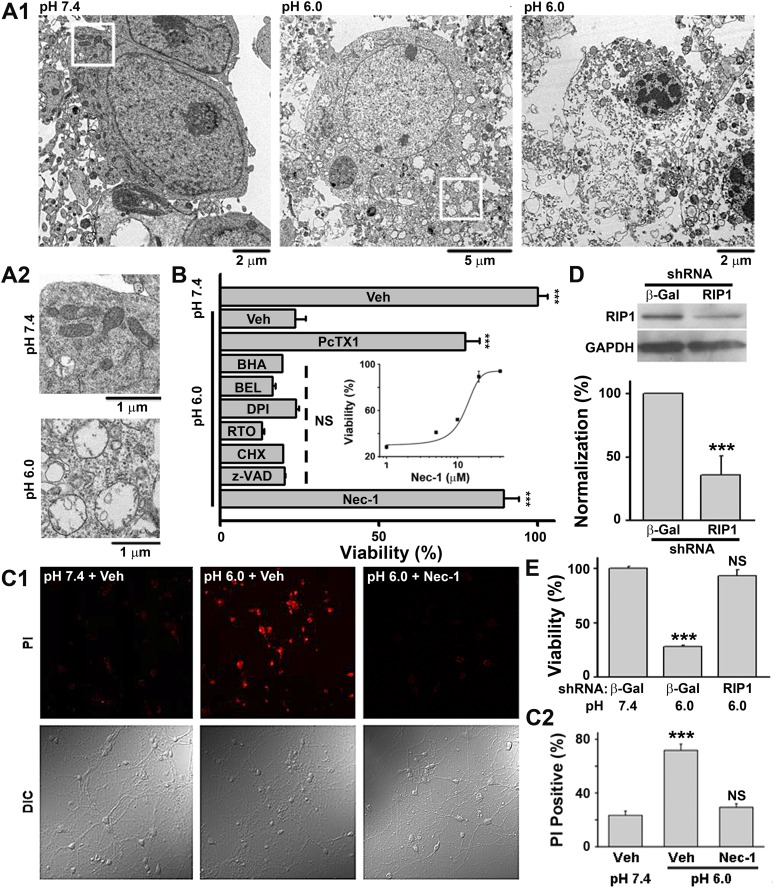
Acid (pH 6.0) induces RIP1-dependent necrotic cell death in cultured mouse cortical neurons.(A1) Electron microscopy images of neurons treated with pH 7.4 (left) or pH 6.0 solution (middle and right). Of 57 cells counted in the pH 6.0-treated samples, 47 showed morphology similar to that shown in the middle and right panels. For pH 7.4-treated samples, the majority of cells had a similar morphology to that shown in the left panel; only 3 out of the 41 cells examined showed morphology that resembled that in the middle panel. (A2) Enlarged images from the white boxes in A1 showing swelling of organelles in pH 6.0- but not pH 7.4-treated neurons. (B) PcTX1 (10 nM) and Nec-1 (20 μM), but not BHA (100 μM), BEL (30 μM), DPI (15 μM), RTO (25 μM), CHX (100 μM), or z-VAD-fmk (10 μM), rescued cells from acid-induced neuronal death (indicated by the dashed line) (n=4–12, ***p<0.001; NS, no statistical significance, vs vehicle (Veh) at pH 6.0). Inset: dose-dependence of the rescue by Nec-1 (CTB assay, n=3–4). (C1) Rescue from acid-induced neuronal death by 20 μM Nec-1 (propidium iodide [PI] staining assay). (C2) Summary data for C1. At least 200 neurons were counted for each condition (***p<0.001; NS, no statistical significance, vs Veh at pH 7.4). (D) Knockdown efficiency of RIP1 shRNA as determined by Western blotting (***p<0.001, vs β-Gal). (E) Rescue of acid-induced neuronal death by RIP1 shRNA (CTB assay, n=3, ***p<0.001; NS, no statistical significance, vs β-Gal at pH 7.4).